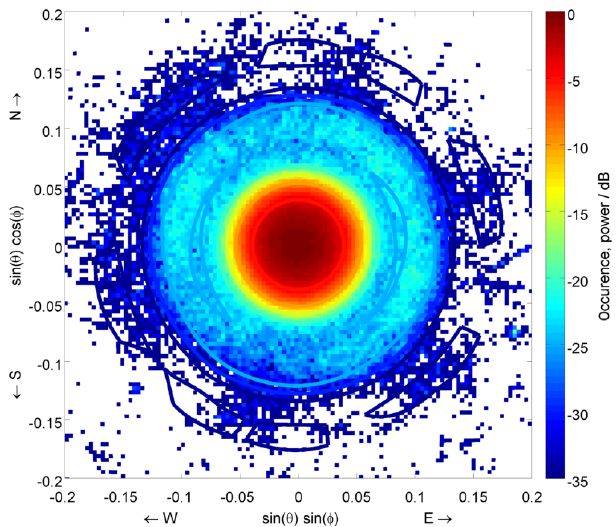
Figure 3. Angular occurrence rate of meteor head echo trajectory points for zenith beam pointing observed with MAARSY during a period of almost 3 months and overlaid by the simulated radiation pattern.